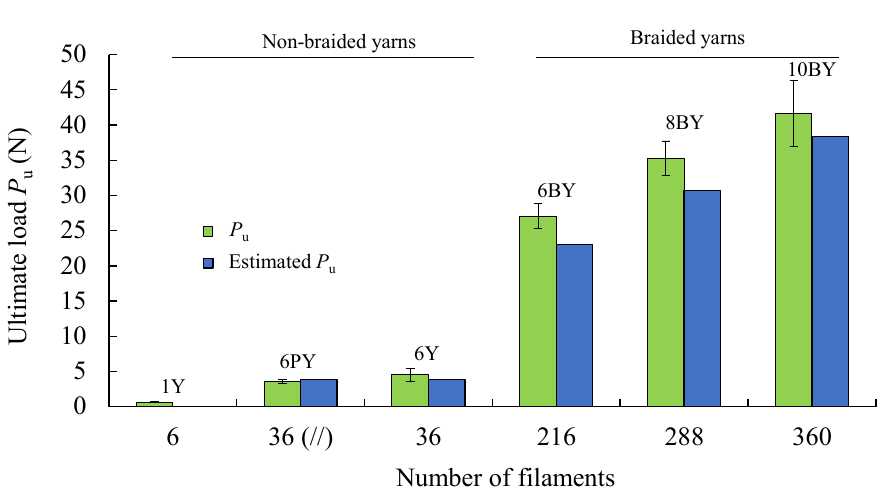
Figure 8. Load–displacement curves of PVA structures: ( a ) 1Y; ( b ) 6PY; ( c ) 6Y; ( d ) 6BY; ( e ) 8BY; ( f ) 10BY.